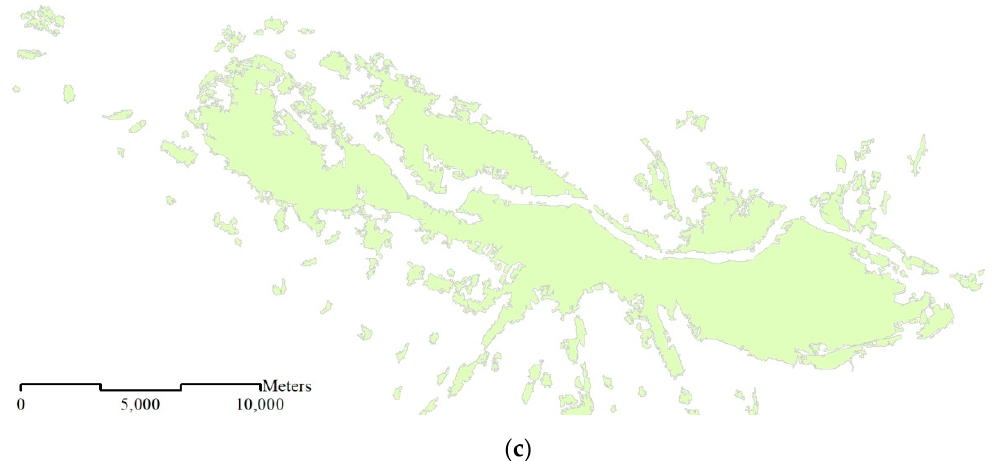
Figure 11. Results of experiments: ( a ) UrbanAreasInitial, ( b ) UrbanAreasInitial_StrBufPolygons_Merge, and ( c ) UrbanAreasInitial2.